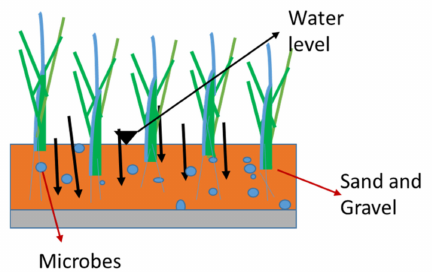
Figure 3. Schematic layout of vertical subsurface flow constructed